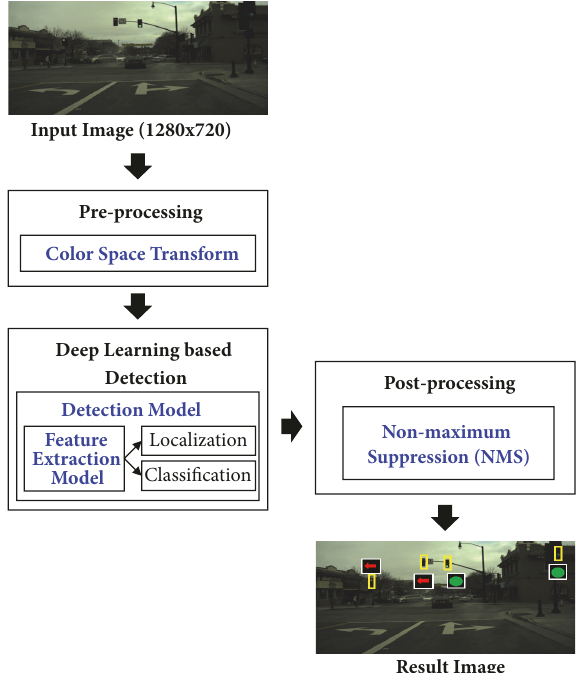
Figure 1: Method overview of deep-learning based traffic light